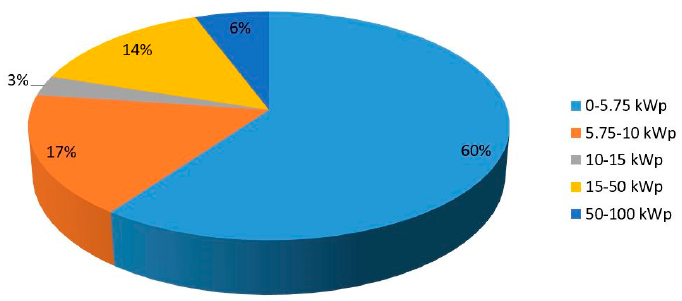
Figure 3. Size distribution of the